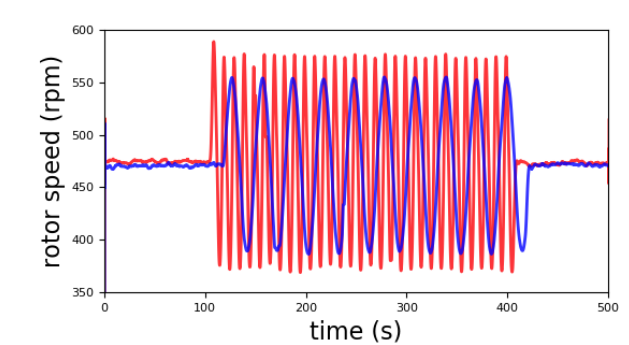
Figure 5. The rotor speed time series for test 1 (red) and test 3